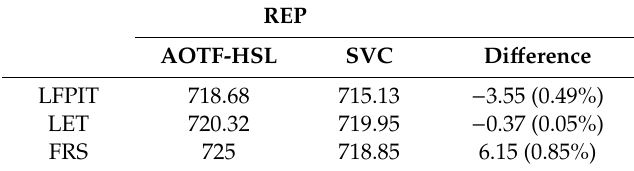
Table 7. The three di ff erent methods’ “Red edge” position results for aloe green